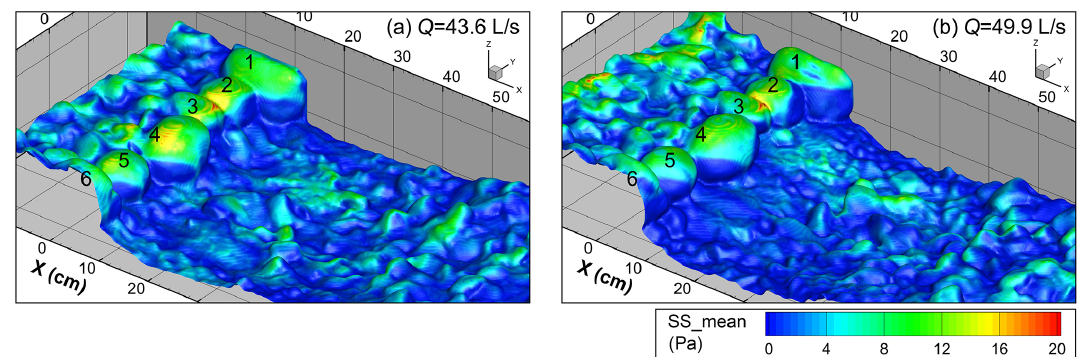
Figure 10. Time-averaged shear stress (SS_mean) on the bed surface in the step-pool model, with the step numbers marked. The standard atmospheric pressure is set as